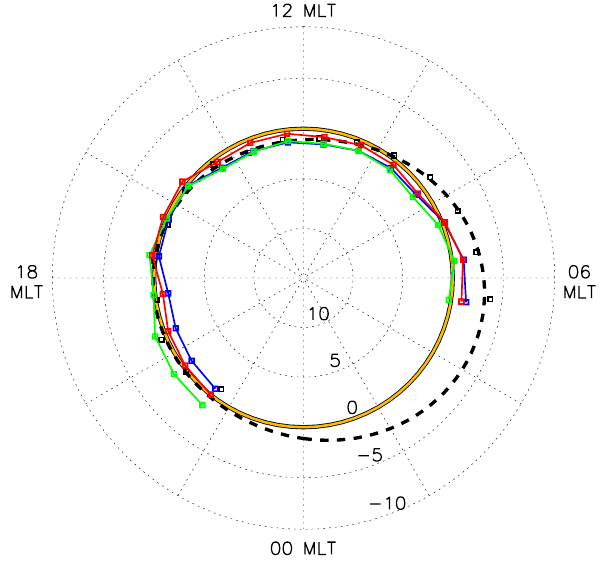
Fig. 6. Optimally estimated latitude differences between WIC (dark blue), SI-13 (red) and SI-12 (green) OCB proxies relative to the latitude of the DMSP OCB proxy (yellow). The fit of Carbary et al. (2003) for Polar UVI boundaries is shown by the black dashed line. Latitude differences between DMSP and Polar UVI OCB proxies from Carbary et al. (2003) are shown by black rectangles and the black dashed line shows the extrapolated fit to all MLTs. Ra- dial co-ordinates represent latitude difference relative to the DMSP OCB proxy in